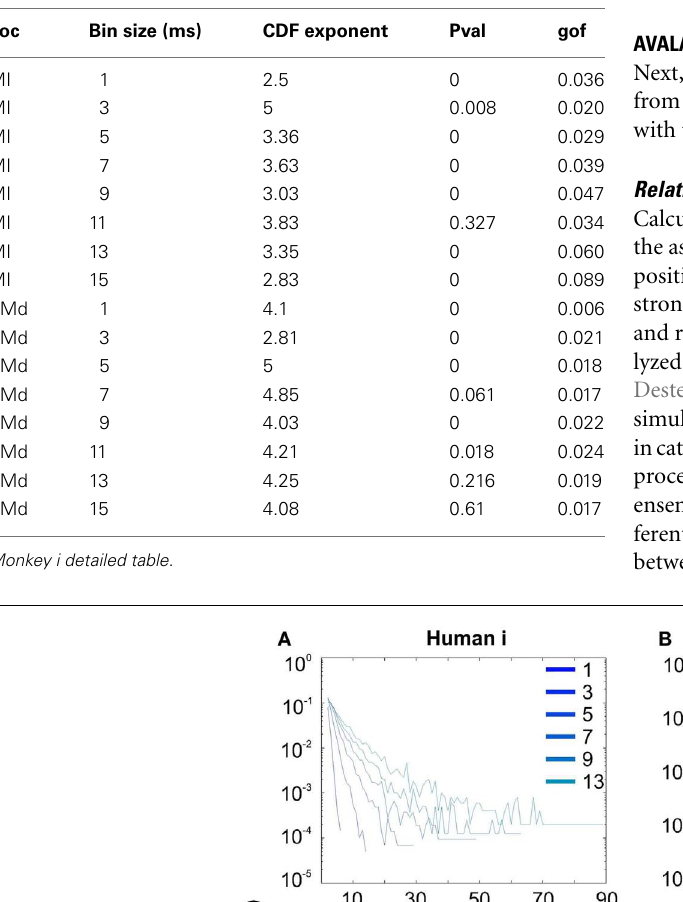
FIGURE 3 | Spike avalanche distributions in log-linear representation. (A–D) Show results for different subjects. Different line colors refer to different bin sizes as shown in the legend. An exponential process has a linear trend in